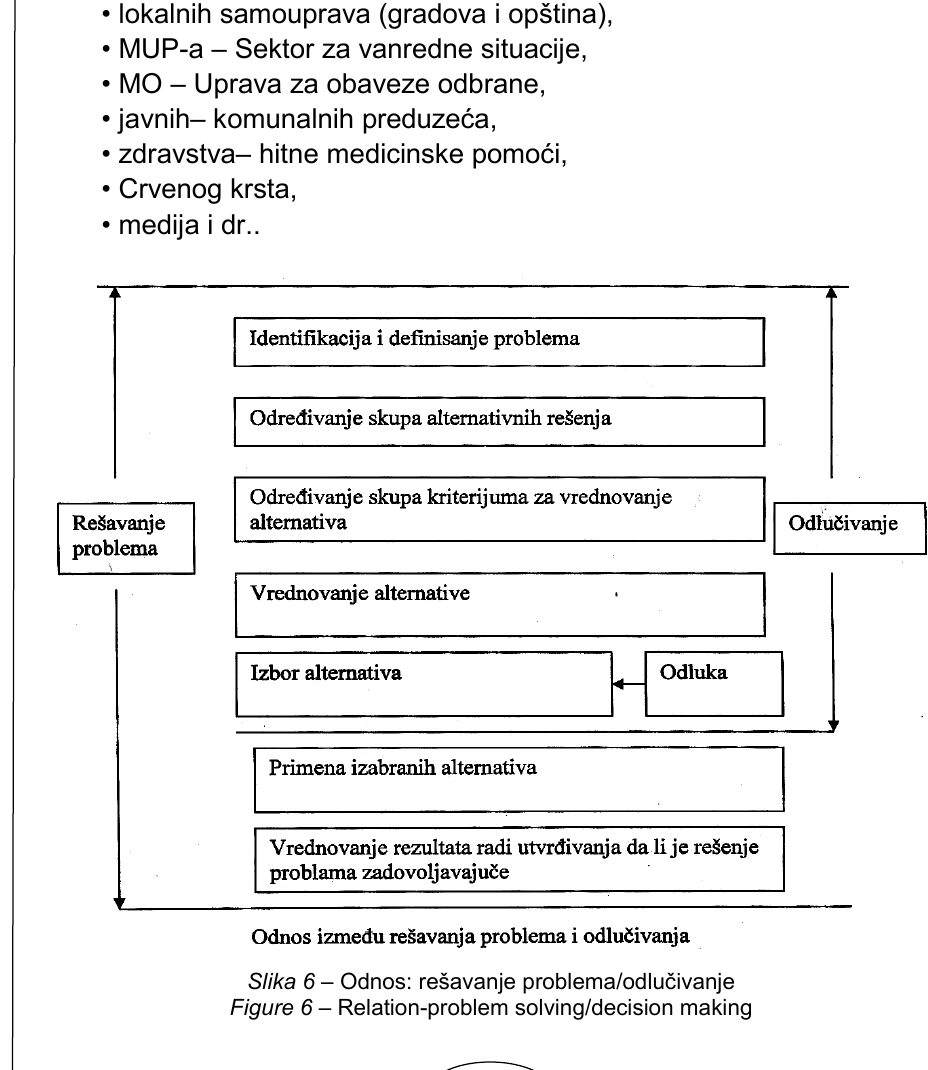
Figure 6 – Relation-problem solving/decision